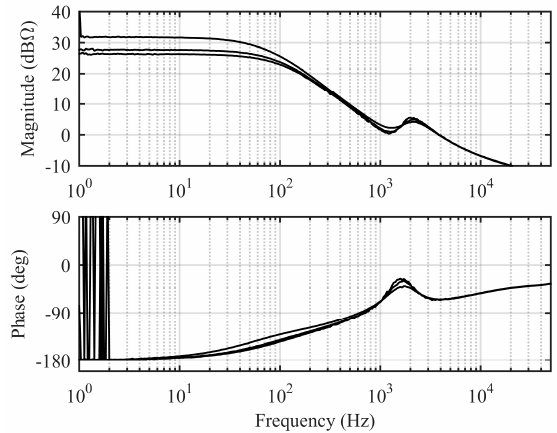
Figure 20. Measured closed-loop input impedance of an output-voltage-feedback-controlled boost converter.